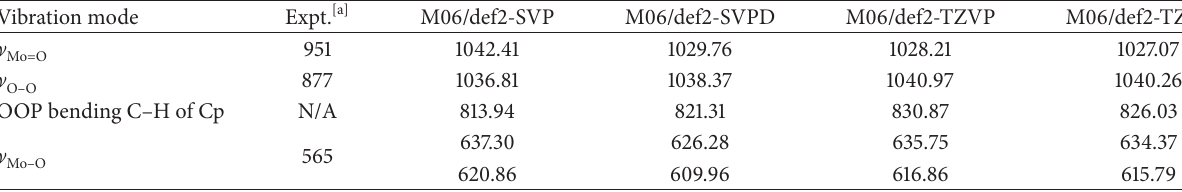
Table 2: Key vibration modes and their respective frequencies calculated at M06 with various basis sets.